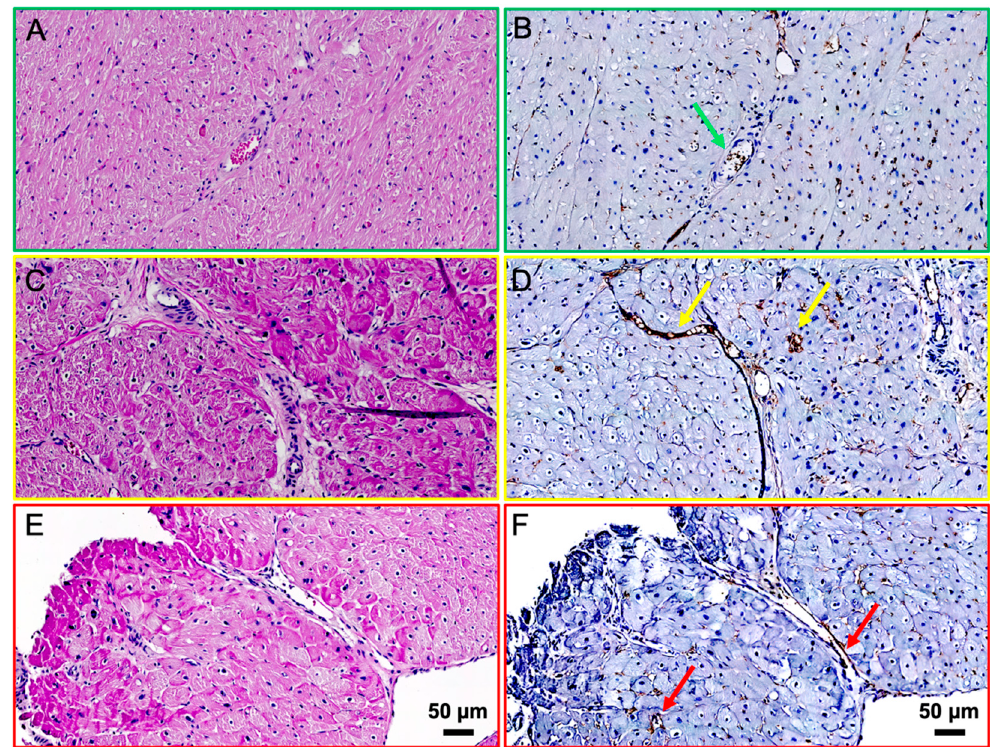
Figure 3. To further support the hypothesis that [ 68 Ga]Ga-RGD PET uptake reflects angiogenesis, biopsies were sampled from the healthy myocardium ( A , B ), infarct border ( C , D ) and infarct area ( E , F ). Classic H&E staining was performed ( A , C , E ). The H&E staining of the infarcted area ( E ), shows a high degree of atypical nuclei and an amyloid-like substance, most likely collagen compared to the infarct boder zone ( C ) or healthy myocardium ( A ). The expression of α v β 3 was evaluated using immunohistochemistry ( B , D , F ) ( α v β 3 , absolute antibody; the antibody was diluted 1:100 and antigen retrieval was performed with proteinase K). The staining indicated a higher α v β 3 expression in the capillaries of the infarct border (( D ), yellow arrows), compared to those in the healthy myocardium (( B ), green arrow) and in the infarcted area (( F ), red arrows). Scale bar (50 µm) is shown in ( E , F ) for size reference.